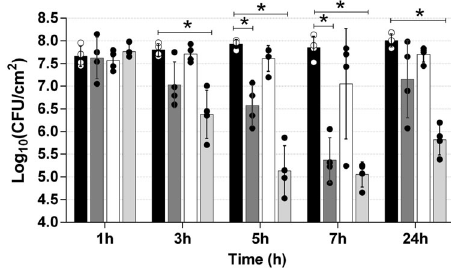
Fig. 3 Time-kill curve of protein CHAPSH3b and/or phage phiIPLA-RODI against S. aureus V329 bio fi lms. 24-h-old bio fi lms were treated with protein at 8 µM (gray bars), phage at 1 × 10 9 PFU/ ml (white bars), or a combination of both (light gray bars) and incubated for 1, 3, 5, 7, or 24 h at 37 °C. Control wells were treated with TSB medium alone (black bars). Data correspond to the means ± standard deviations of four independent experiments and represented in logarithmic scale in colony-forming units per cm 2 of bio fi lm. Bars with an asterisk are statistically different ( p < 0.05) from the untreated control according to the Student ’ s t-test using the Holm-Sidak